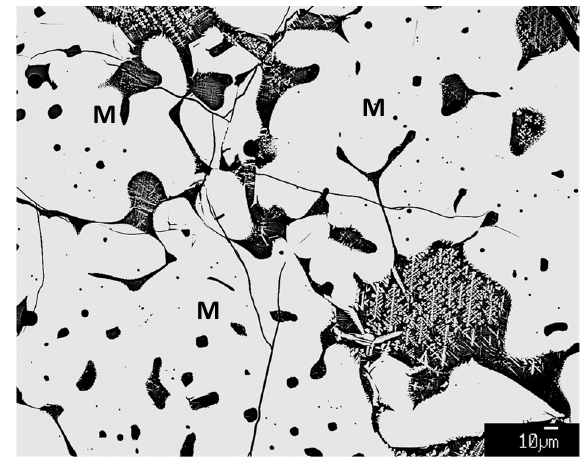
Figure 21. Magnetite and associated microstructures observed from magnetite formed at 1400 °C in air (94.33 wt % Fe 2 O 3 and a CaO/SiO 2 ratio of 5.32 wt/wt) (M—Magnetite) (BSE Micrograph).